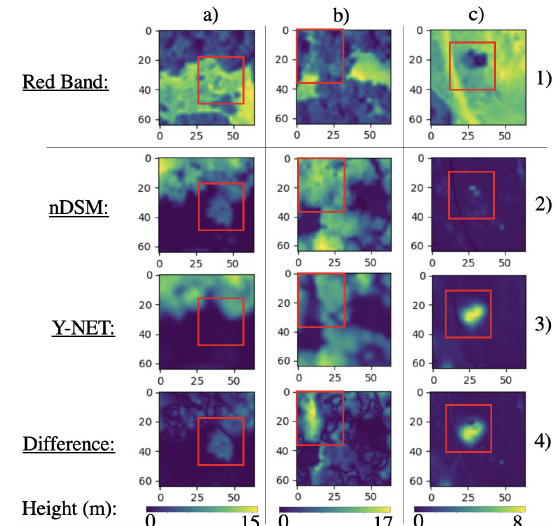
Figure 11. Examples of Y-NET with 2006-2007 LiDAR and 2016 NAIP imagery. The column labels ( a – c ) are used with the row numbers to reference each